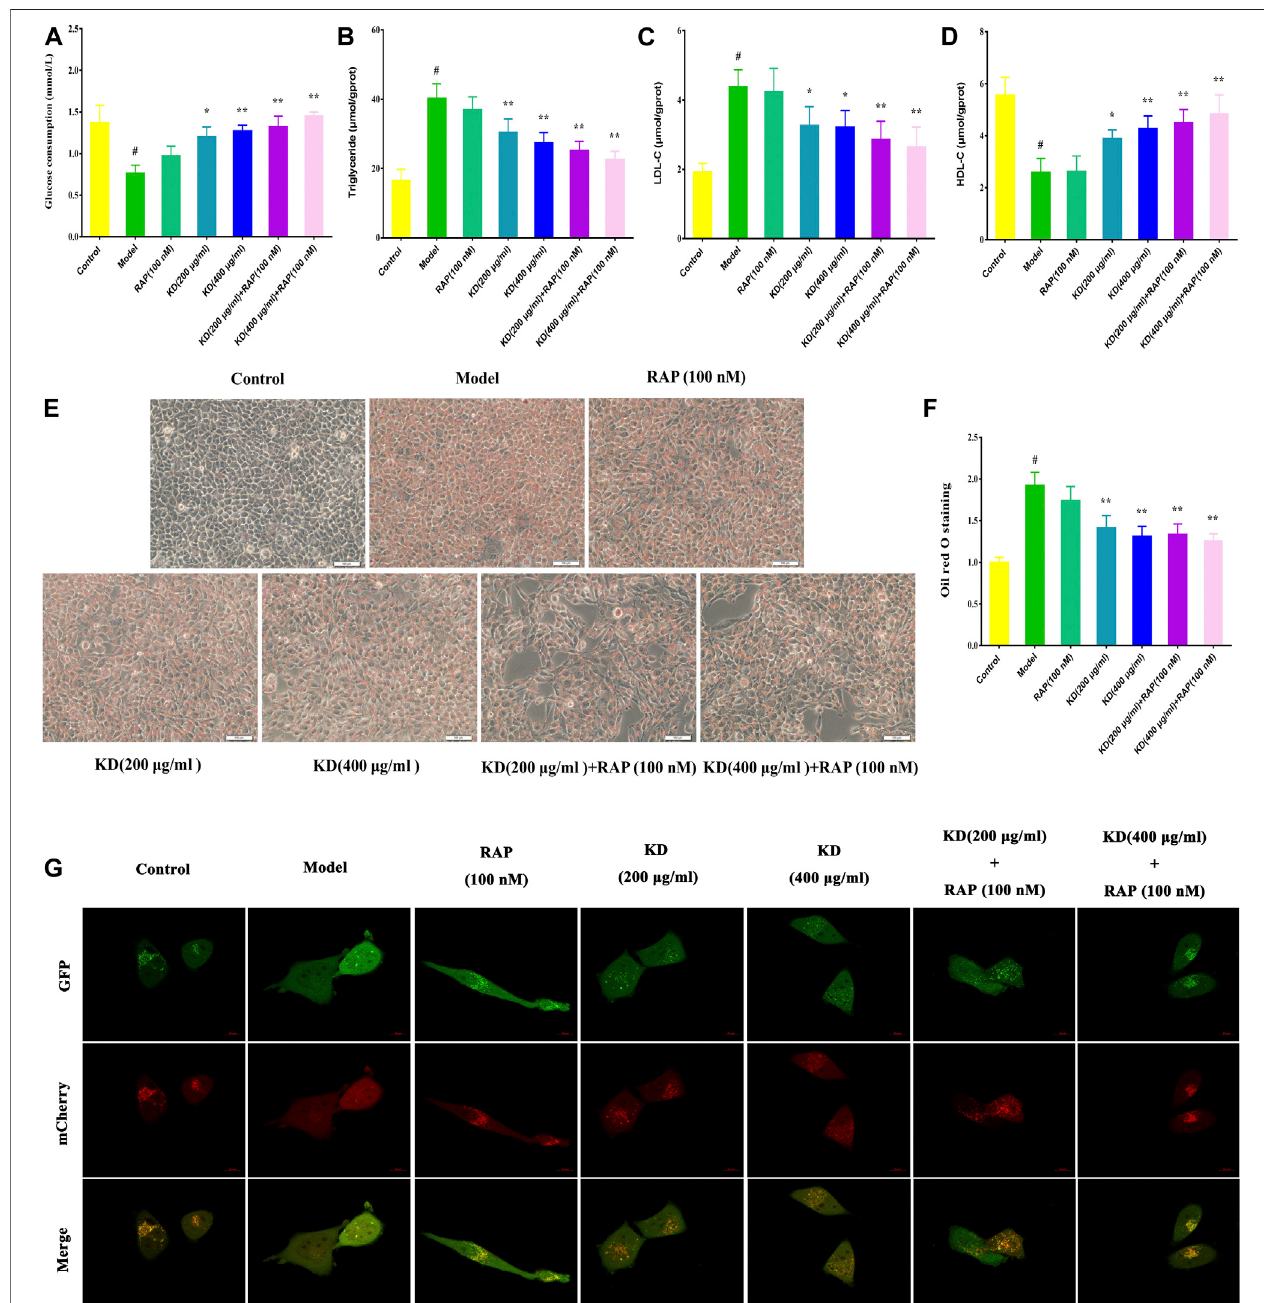
FIGURE 7 | Rapamycin strengthens the therapeutic effect of KD on insulin resistance in hepatocytes. LO2 cells were incubated in DMEM with 0.5% fatty acid-free BSA or oleic acid (0.25 mM) for 24 h, and then were pretreated with RAP (100 nM) for 1 h and were treated with or without KD (200 and 400 μ g/ml) for 24 h. (A) The glucose consumption of hepatocytes; (B – D) The intercellular triglyceride, LDL-C and HDL-C contents of oleic acid-induced hepatocytes; (E – F) The oil red O staining of oleicacid-inducedhepatocytes; (G – H) Theautophagy fl uxofhepatocytes; (I – Q) Westernblotanalysisforp62 (I) ,Atg5 (J) ,Atg7 (K) ,Atg13 (L) ,LC3- Ⅱ / Ⅰ (M) ,AMPK, p-AMPK (Thr172) (N) , mTOR and p-mTOR (Ser2448) (O) . Data were presented as mean ± SD ( n (cid:2) 3 in each group). # P < 0.01 compared with the control group, * P < 0.05, ** P < 0.01 compared with the model group.